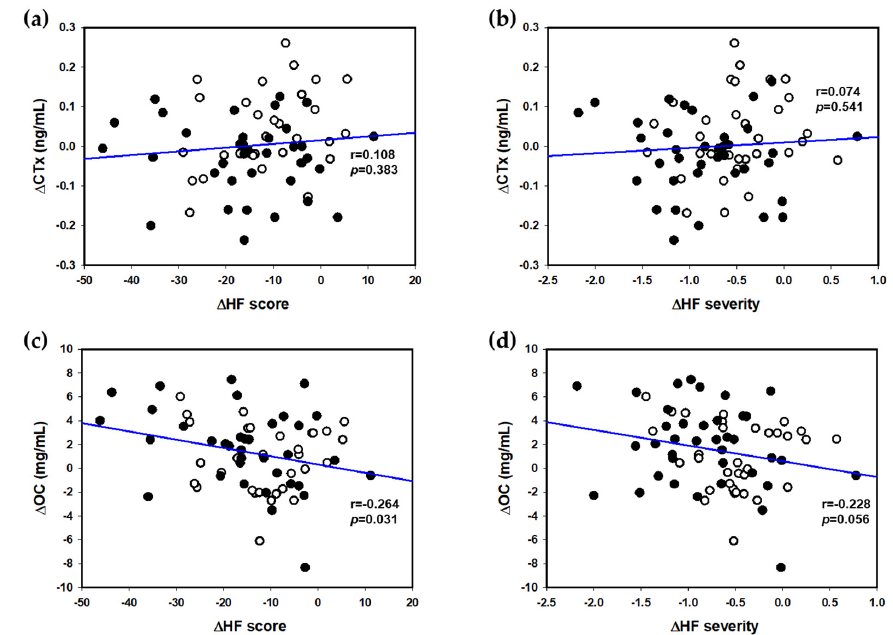
Figure 3. Associations between differential scores and bone turnover markers. CTx was positively correlated with HF scores ( a ) and HF severity ( b ), while OC was negatively correlated with HF scores ( c ) and HF severity ( d ). Dots are experimental points (KM: black circles, placebo: empty circles), and the continuous line indicates the straight-line fit by linear regression. KM, an extract mixture of kudzu flower and mandarin peel; HF, hot flashes; CTx, cross-linked C-telopeptides of bone collagen; OC, osteocalcin.